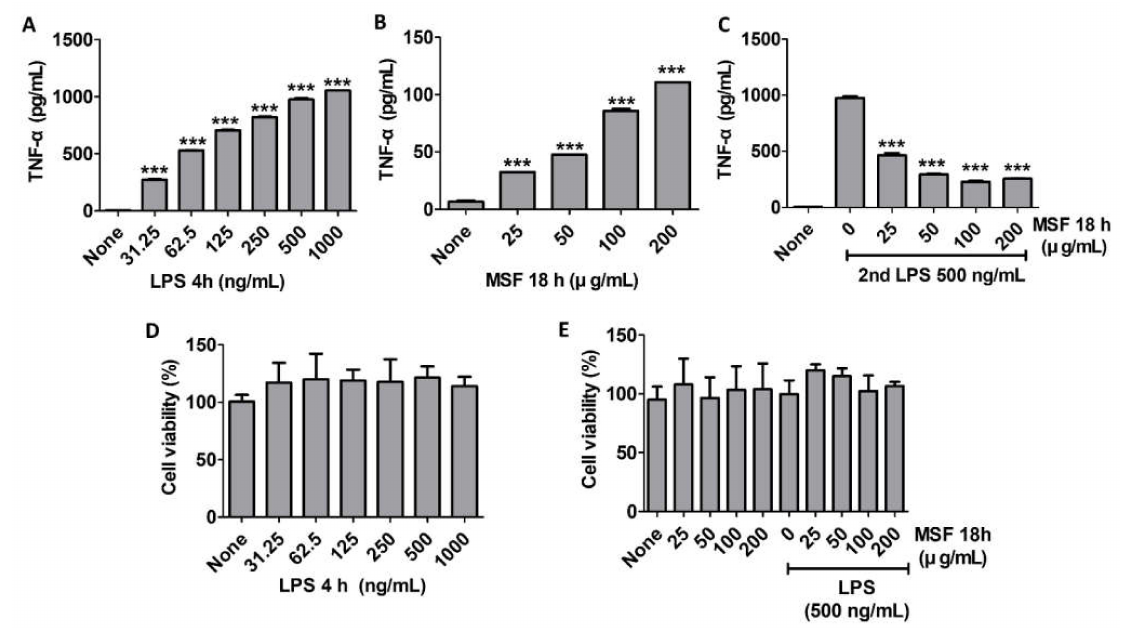
Figure 1. TNF- α expression in THP-1 cells by MSF and LPS treatment. ( A ) THP-1 cells were treated with lipopolysaccharide (LPS) at the indicated concentration for 4 h. ( B ) THP-1 cells were treated with MSF at the indicated concentration for 18 h. ( C ) THP-1 cells were pretreated with MSF at the indicated concentration for 18 h and were retreated with LPS at a concentration of 500 ng/mL for 4 h. The level of tumor necrosis factor-alpha (TNF- α ) in the culture supernatants was measured by enzyme-linked immunosorbent assay (ELISA). ( D ) THP-1 cells were treated at the indicated concentration for 4 h. ( E ) THP-1 cells were pretreated with MSF at the indicated concentration. After 18 h, the cells were treated with 500 ng/mL LPS for 4 h. Cell viability was measured using a trypan blue assay. Statistical analysis was conducted with one-way ANOVA followed by Tukey’s HSD post hoc test. *** p <